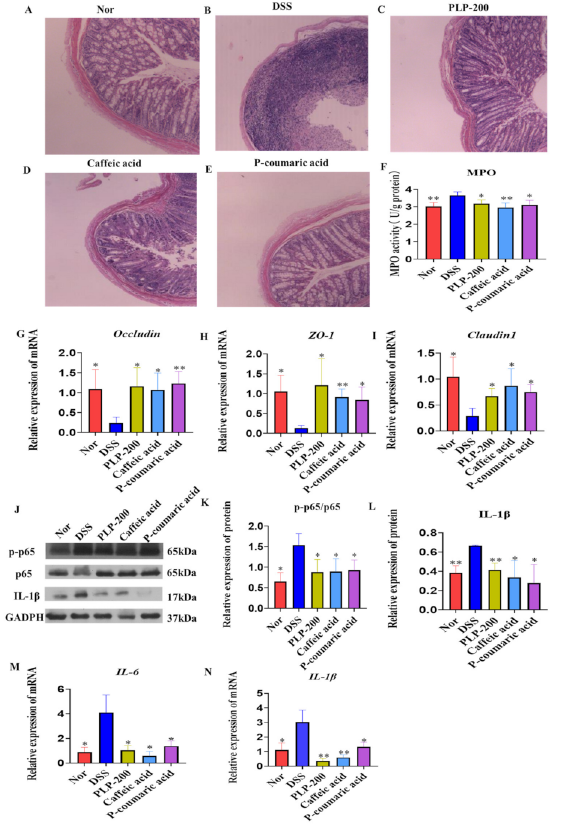
Figure 2. PLP, Caffeic acid, and P-coumaric acid slowed down the loss of tight junction proteins in colonic epithelial tissue and the infiltration of immune cells, and they inhibited the secretion of pro-inflammatory factors and the activation of NF- κ B cell signaling in the colon tissue of DSS-induced colitis mice ( A – N ). Representative histopathological images at 100 × magnification ( A – E ). Colonic MPO activity ( F ). ZO-1, occludin, and claudin 1 mRNA in colon tissue were determined by real-time PCR ( G – I ). p-p65, p65, and IL-1b were detected by Western blot ( J – L ). IL-6 and IL-1 β mRNA in colon tissue were determined by real-time PCR ( M , N ). Nor: normal control mice; DSS: colitis model control mice fed dextran sulphate sodium salt; PLP-200: pineapple leaf phenols-treated (200 mg/kg) DSS mice; Caffeic acid: Caffeic acid-treated (50 mg/kg) DSS mice; P-coumaric acid: P-coumaric acid-treated (50 mg/kg) DSS mice. Data are expressed as the mean ± SD (n = 7); * p < 0.05, ** p < 0.01 compared to the mice treated with DSS